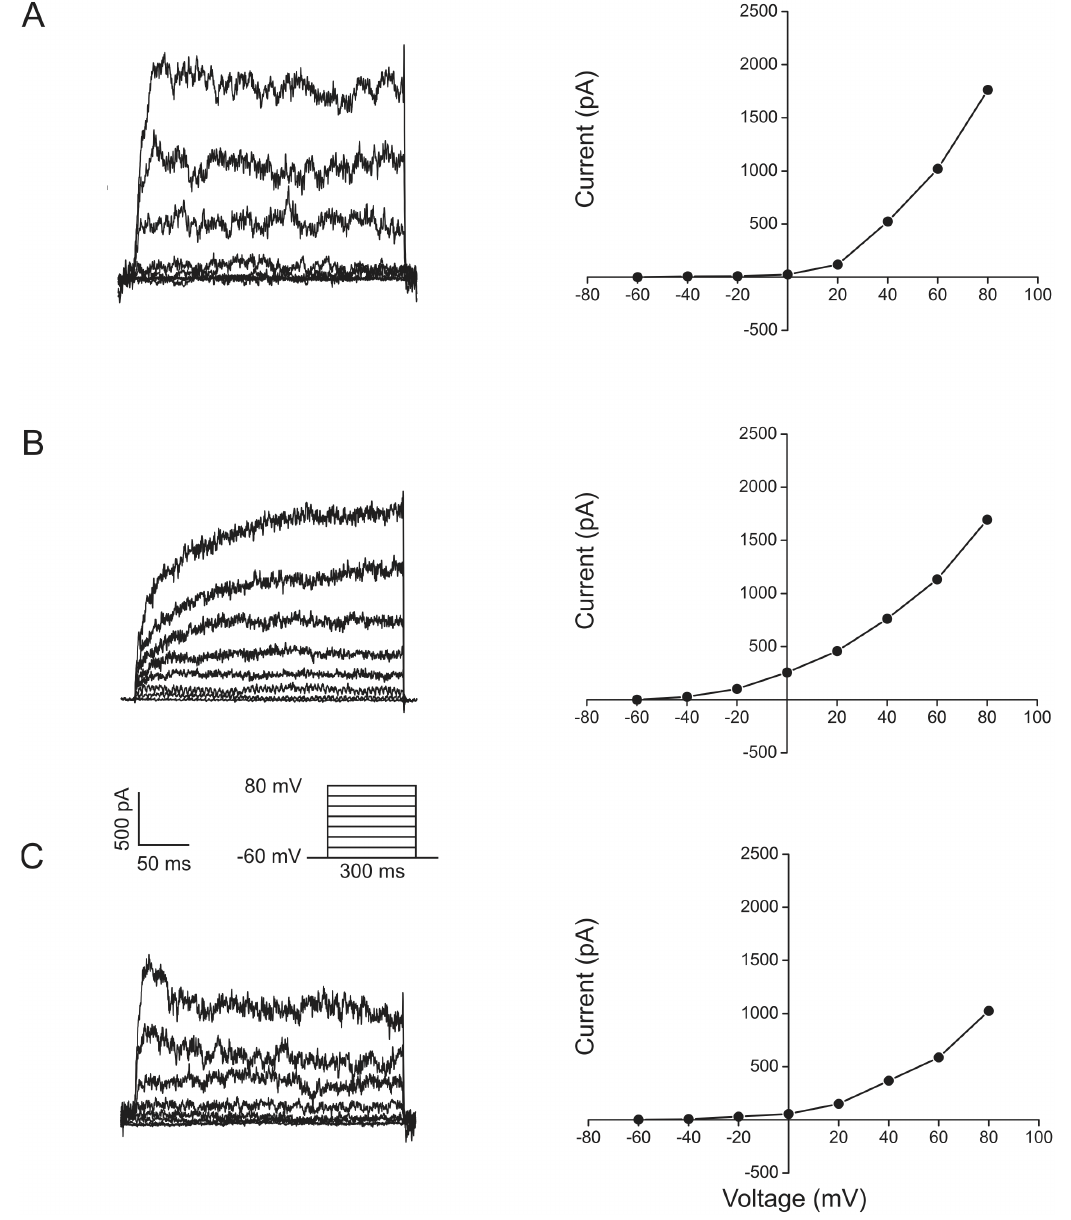
Figure 2. Whole-cell currents elicited in ASCs subjected to normoxic or hypoxic growth conditions. ASCs cultured in 20% and 5% oxygen tension for 4 days exhibited similar outward current patterns. Representative recordings are presented along with the respective current- voltage relationships. (A) Cell with a predominant Ca 2 + -activated K + component (IK Ca ). (B) Cell with a predominant slowly activating delayed rectifier component (IK DR ). (C) Cell displaying a transient outward component (I to ).